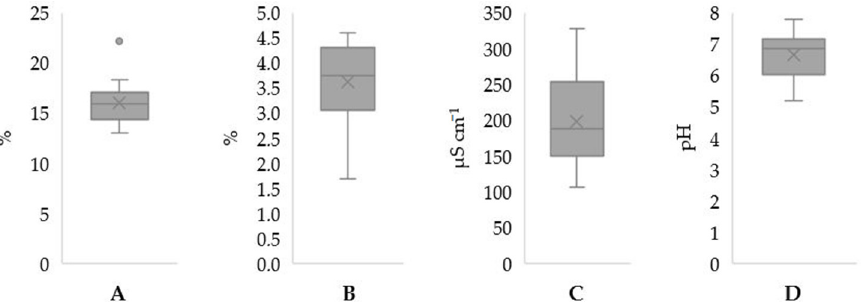
Figure 1. Boxplots of humidity ( A ), organic matter ( B ), electrical conductivity ( C ) and pH ( D ) of soil samples ( n = 16) from the orchard of Pyrus communis var. Rocha from Alcobaça, Portugal.